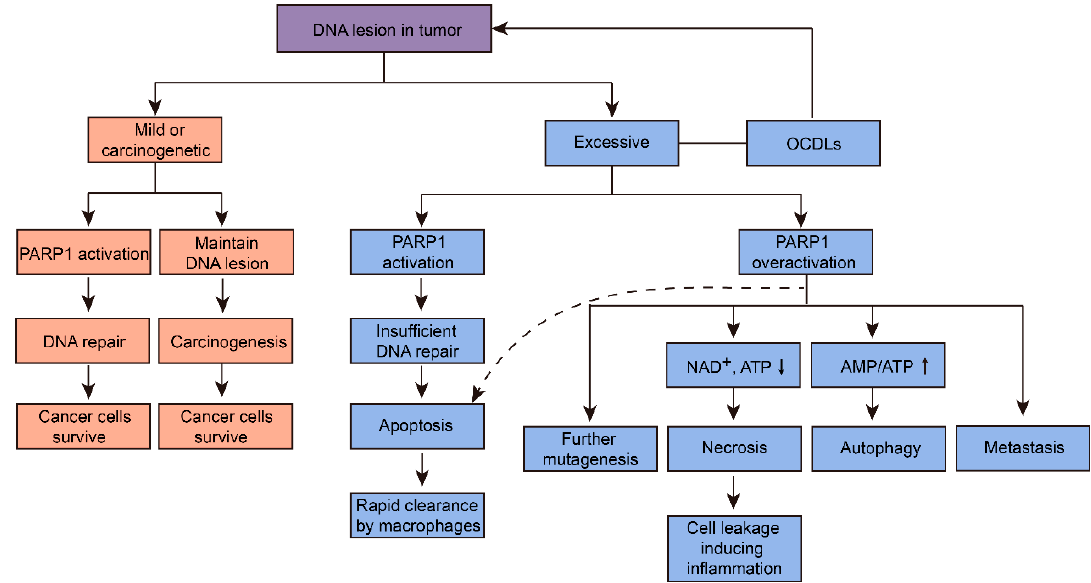
Figure 2. Cancer cells fate induced by different levels of PARP1-related DNA repair in tumor. PARP1